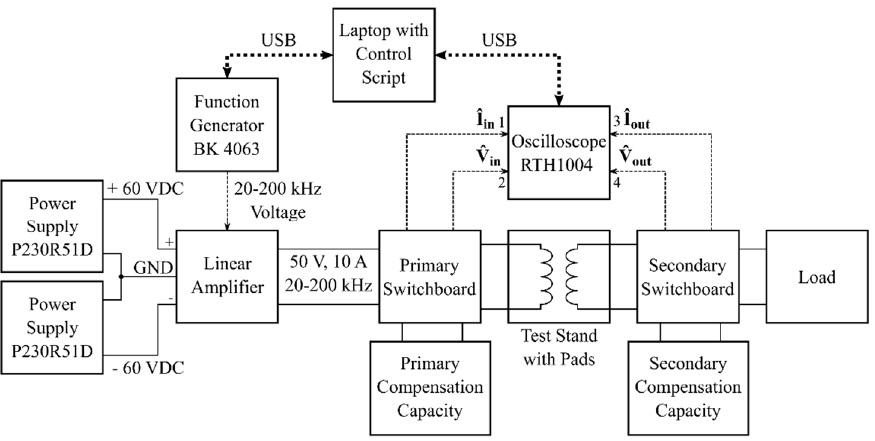
Figure 5. Measurement setup block diagram.